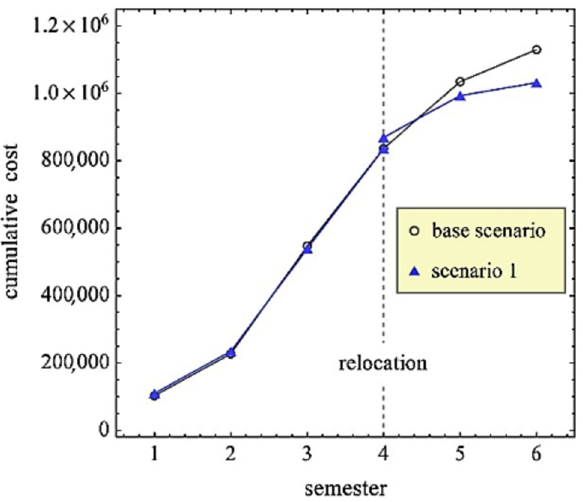
Figure 5. Comparison of cumulative costs.